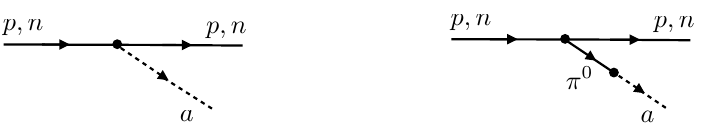
Figure 4 . Diagrams contributing to the effective ALP-nucleon coupling in chiral effective theory.